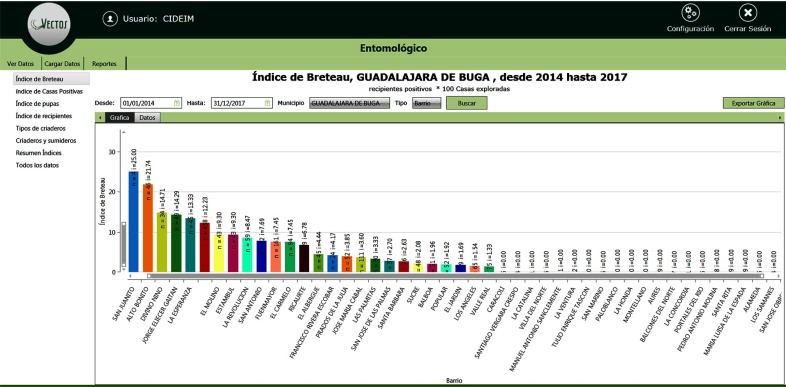
VECTOS Graphical Output of Entomological Breteau Indexa for Each Neighborhood in Buga, Colombia, January 1, 2014–December 31, 2017aNumber of positive containers per 100 houses.